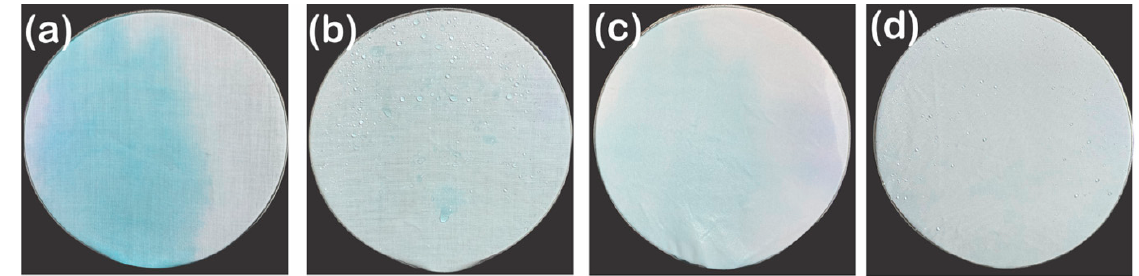
Figure 8. Photographs of fabrics after water spraying test: untreated ( a ) anP1T1 PDMS-coated staple fabric ( b ) and untreated ( c ) and P1T1 PDMS-coated filament fabric ( d ).